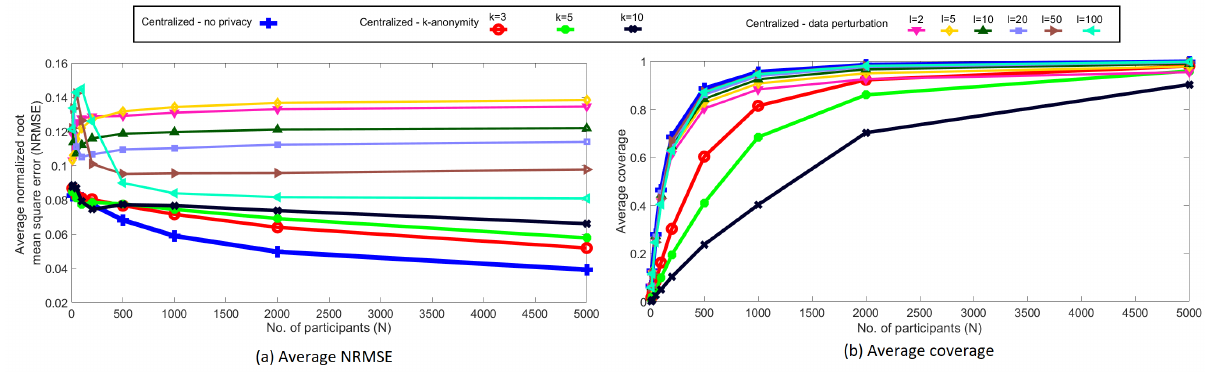
Figure 7: Average NRMSE and coverage for various centralized spatial interpolation techniques